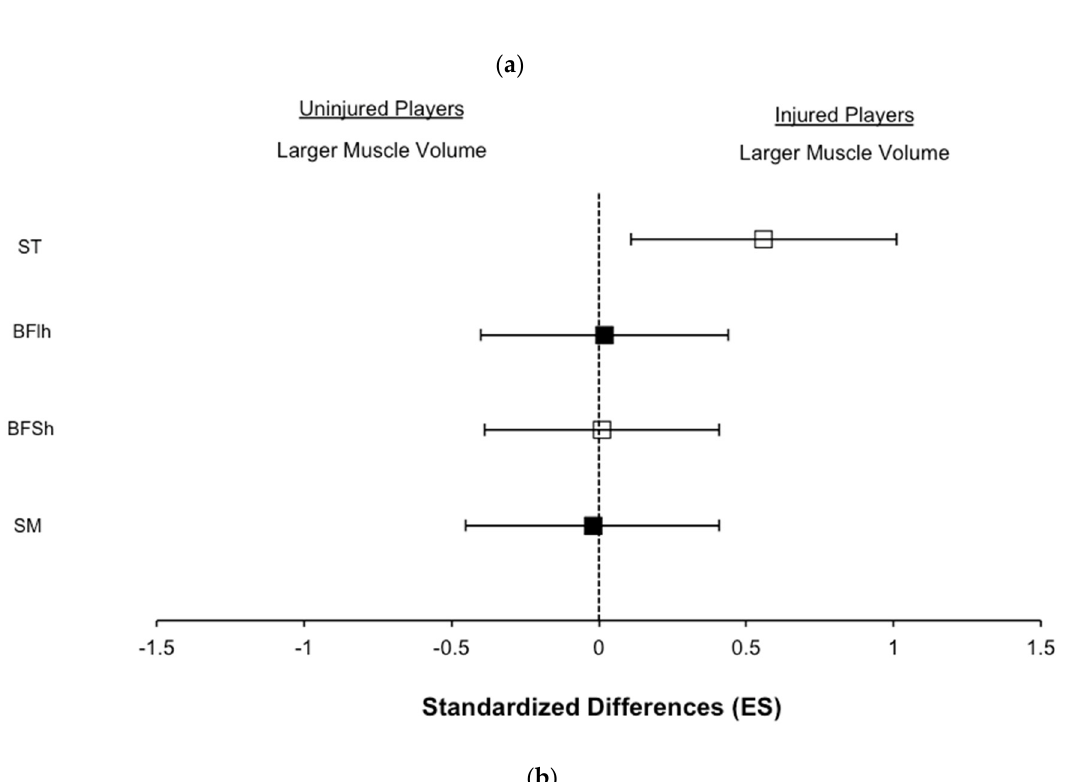
Figure 2. Standardized differences in hamstring muscle volume for the semitendinosus (ST), biceps femoris long head (BFlh), biceps femoris short head (BFSh), and semimembranosus (SM) muscles assessed with magnetic resonance image (MRI). ( a ) Comparison between the injured limbs vs. uninjured limbs among players with a prior hamstring injury. ( b ) Comparison between the injured limbs of players with a prior hamstring injury vs. all uninjured limbs among the uninjured players. Table 3. Comparison of muscle volume for the semitendinosus (ST), biceps femoris long head (BFlh), biceps femoris short head (BFSh), and semimembranosus (SM) muscles assessed with mag- netic resonance image (MRI) between the injured players (i.e., players with a history of a previous injury within the last two competitive seasons) and all uninjured limbs in the uninjured players.